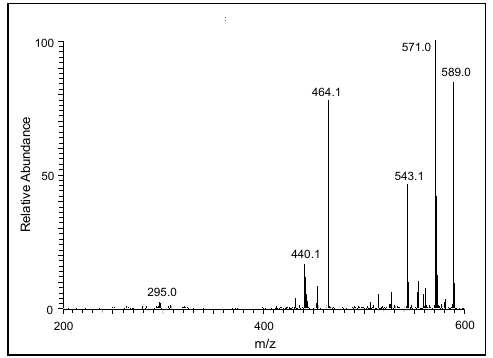
Figure 8. The CID mass spectrum of the ion with an m / z value of 589 amu.